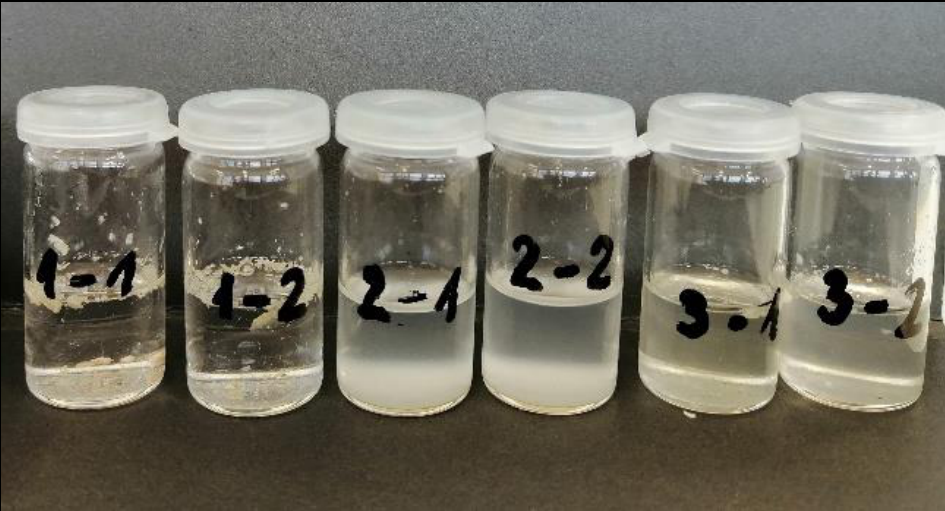
Figure 7. Solubility of the adhesives in acetone (1), n-hexane (2) and dichloromethane (3); the first number represents the used solvent, while the second number represents the used adhesive.